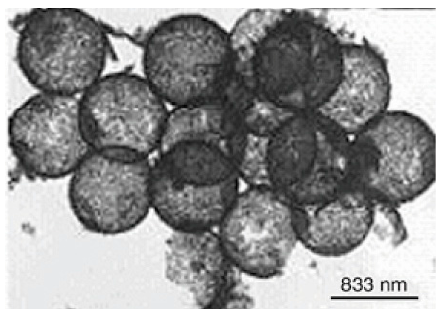
Figure 4. Transmission electron microscopy (TEM) image of Eu 2 O 3 hollow sphere [68].